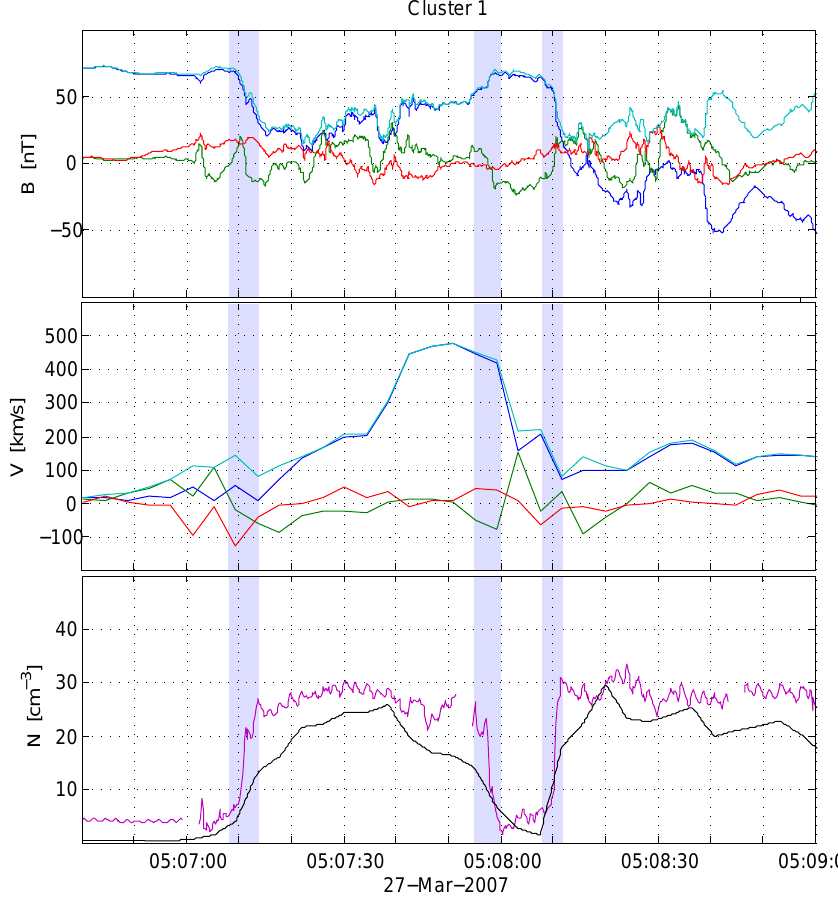
Fig. 4. A detail from Fig. 3: Cluster 1 observation at 05:07:40–05:09:00UT. B and V are in same format as in Fig. 3. In the ion density panel, the black curve is the CIS/HIA ion measurement (same as in Fig. 3) and the magenta curve is density estimate derived from the EFW spacecraft potential measurement, added here because it has higher time resolution. The 4-s oscillation is due to spacecraft spin. Blue vertical bars mark the three partial magnetopause crossings during this interval. If reconnection at the magnetopause were continuous and steady, the reconnection jet should be observed at all three